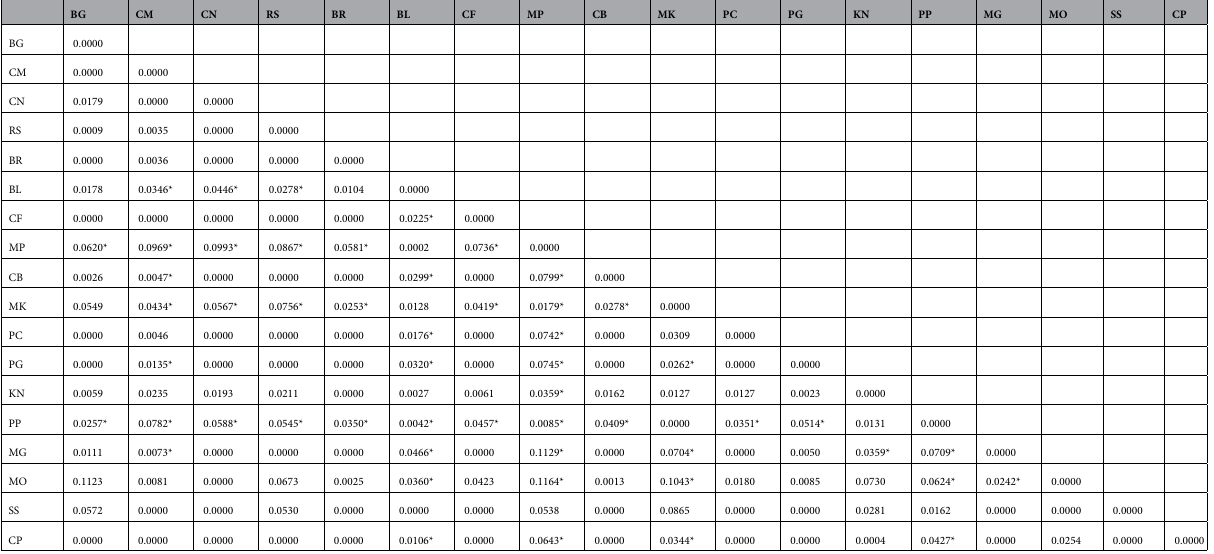
Table 4. Pairwise differences (F ST ) among populations. For abbreviations of population names, see Table 1, *Indicates significant P values ( P <